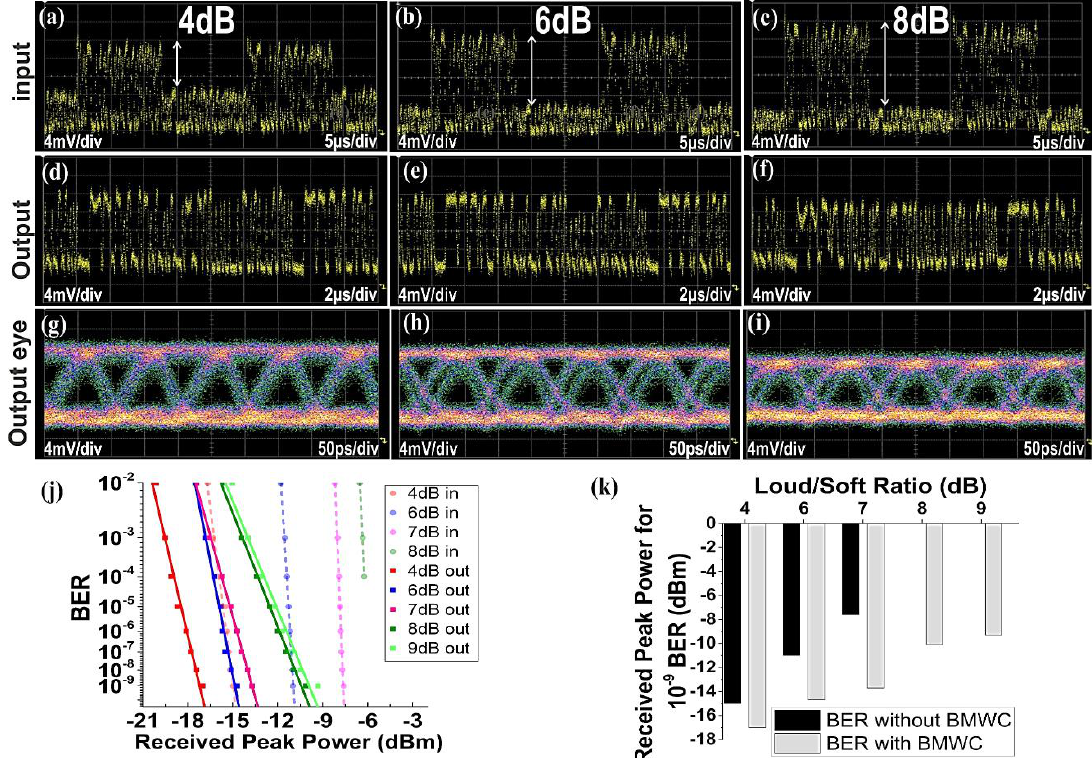
Figure 2. Experimental results for 10 Gb/s for 4 dB loud/soft ratio ( a ) input trace (5 μs/div), ( d ) output trace (2 μs/div), ( g ) output eye diagram (50 ps/div). For 6 dB ( b ) input trace, ( e ) output trace, ( h ) output trace (2 µ s / div), ( g ) output eye diagram (50 ps / div). For 6 dB ( b ) input trace, ( e ) output trace, ( h eye diagram. For 8 dB ( c ) input trace, ( f ) output trace, ( i ) output eye diagram, ( j ) Bit Error Rate (BER)